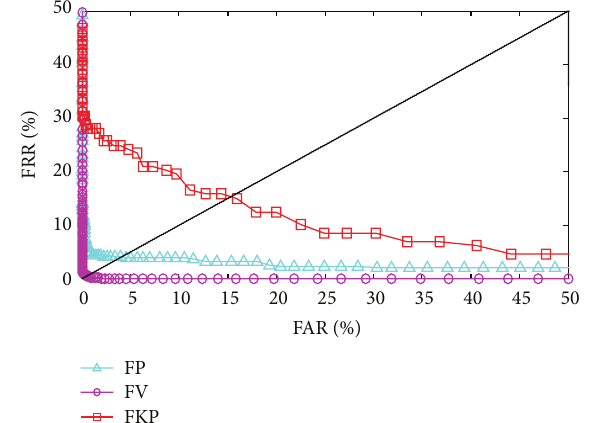
Figure 6: Comparisons between unimodal biometric systems.